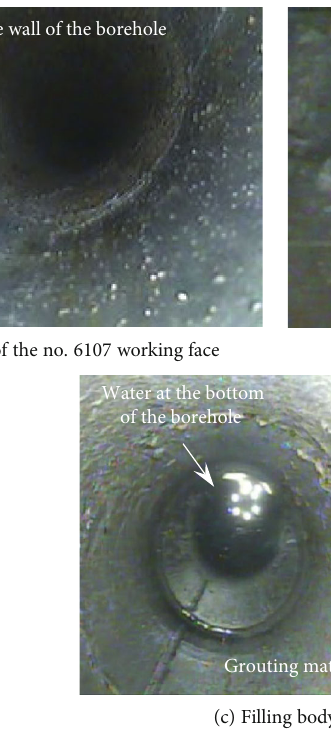
Figure 14: D1 borehole TV observation results at di ff erent